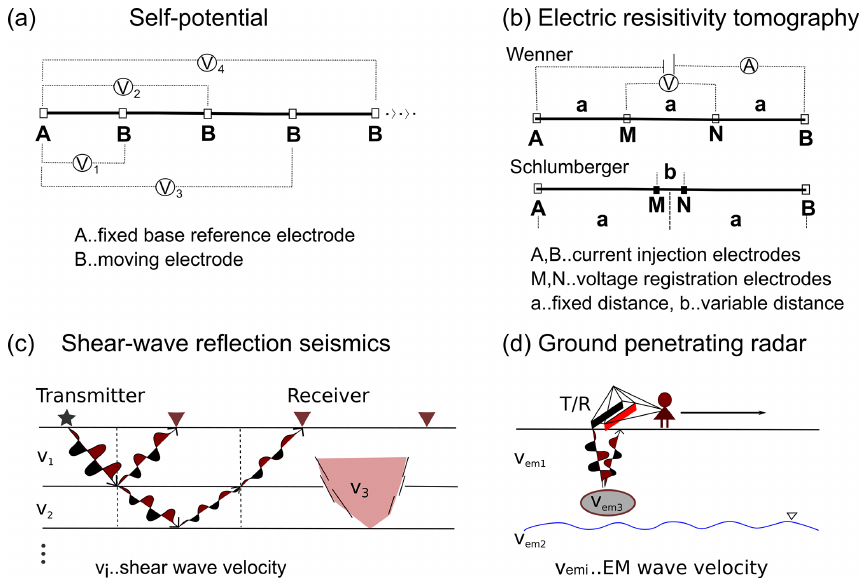
Figure A1. Simplified sketches of the survey layouts used for the geophysical methods in this study. (a) Self-potential with fixed base configuration applied to an array. (b) Electric resistivity tomography using Wenner and Schlumberger electrode configurations. (c) Shear